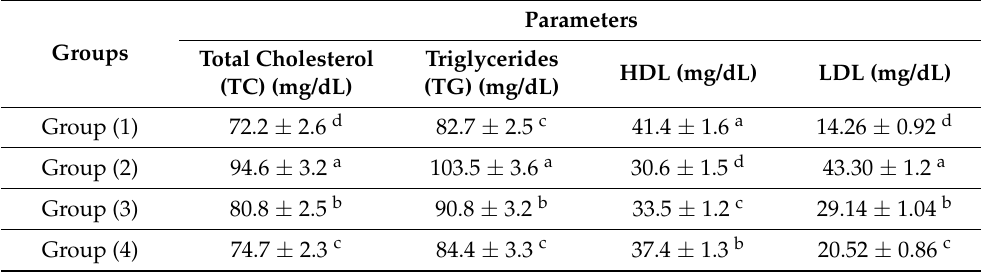
Table 5. Effect of fermented camel milk supplemented with SFP on the serum lipid profile in diabetic